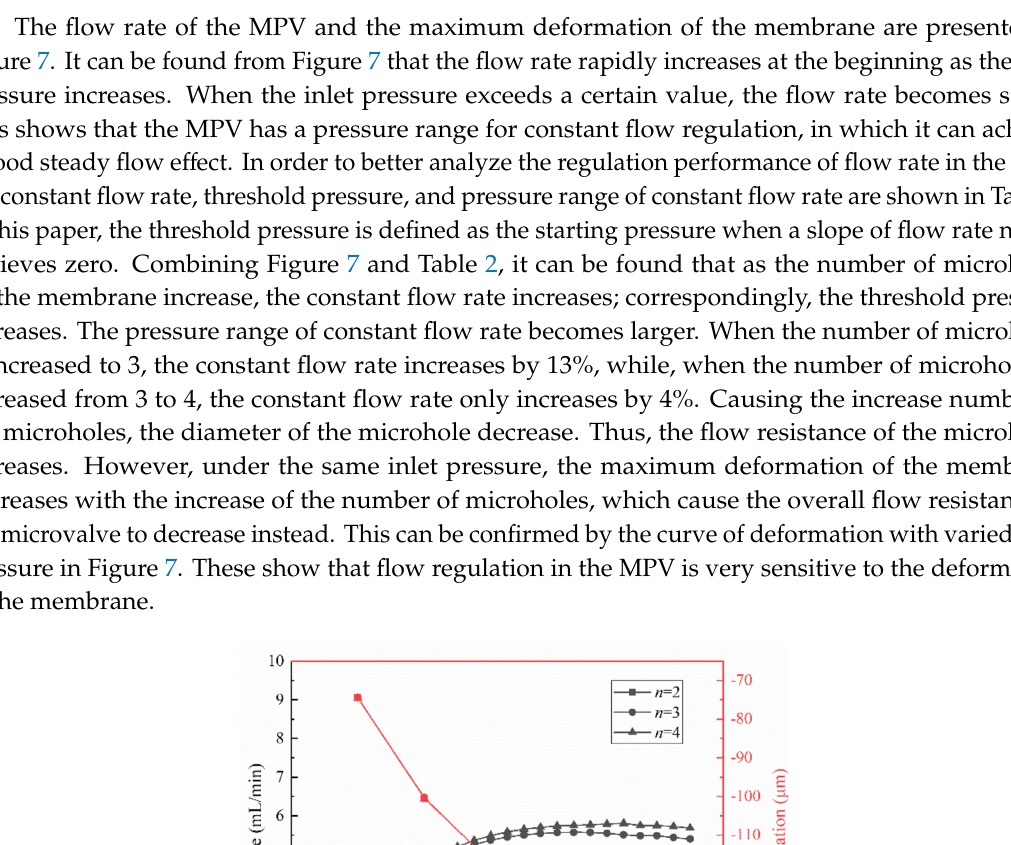
Figure 6. Velocity contours for different inlet pressure in symmetry planes, ( a ) n = 2, ( b ) n = 4.